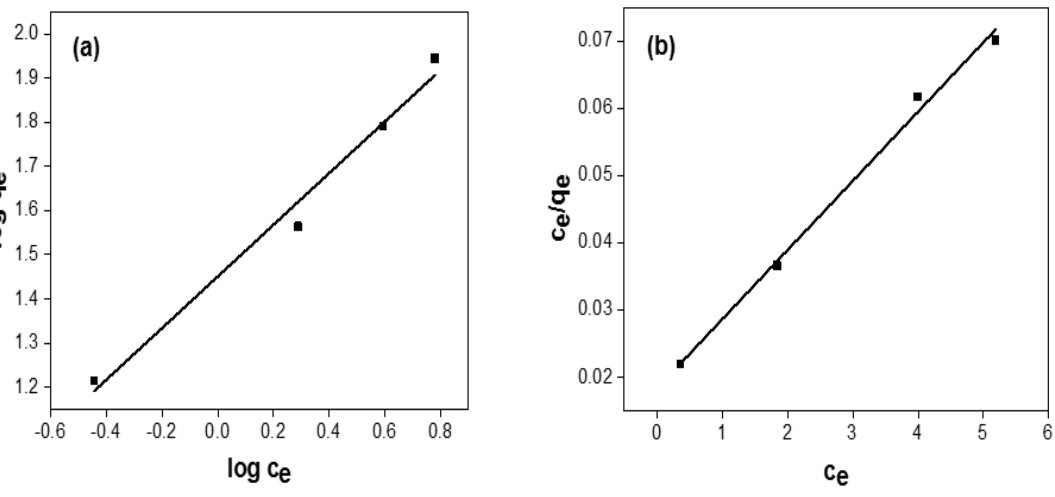
Figure 4. ( a ) Freundlich isotherm; ( b ) Langmuir isotherm for sorption of dyes using CPSMNPs. Table 4. Freundlich and Langmuir isotherm constants for MY adsorption on CPSMNPs. Isotherm Parameters Values Freundlich isotherm